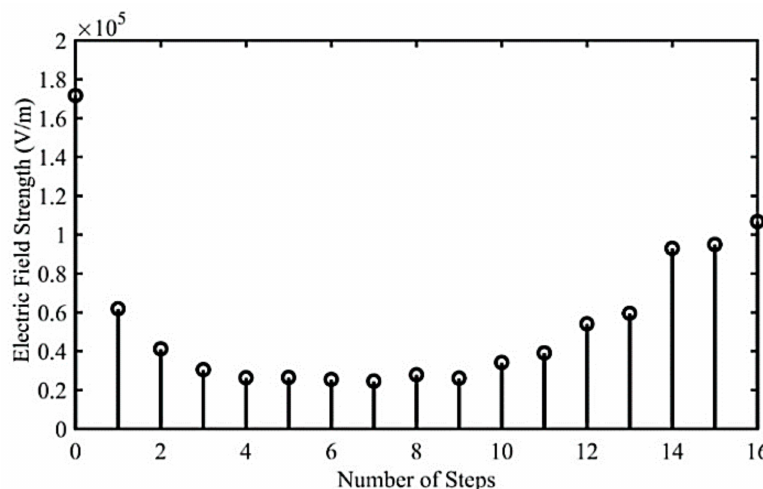
Figure 14. Line plot of silica sand